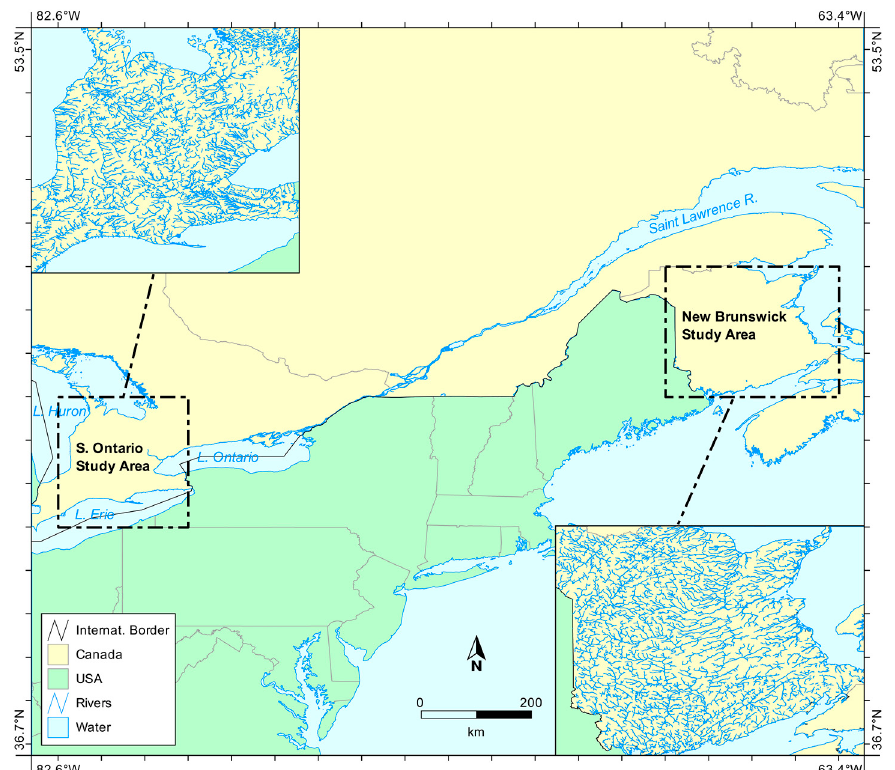
Figure 2. The locations of two study areas (marked by thick dashed black lines) used in testing the new vector drainage network analysis algorithm. The top inset map details the major drainage features of the Southern Ontario study area and the bottom inset details the New Brunswick site.